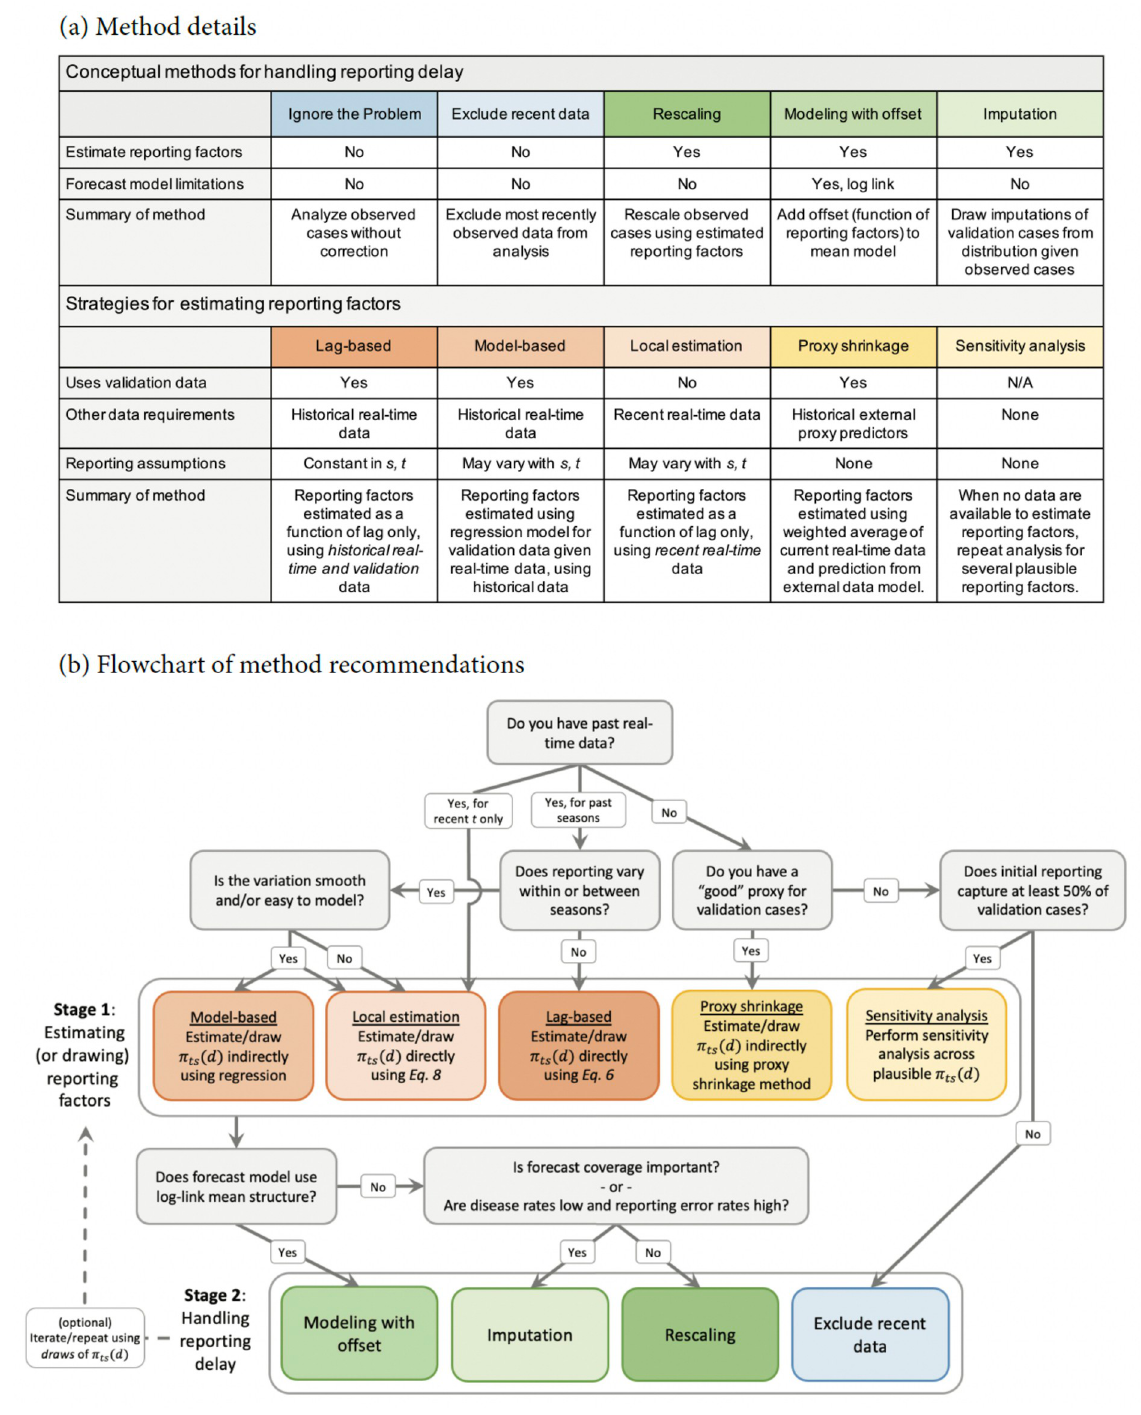
Fig 2. Summary of methods for handling reporting